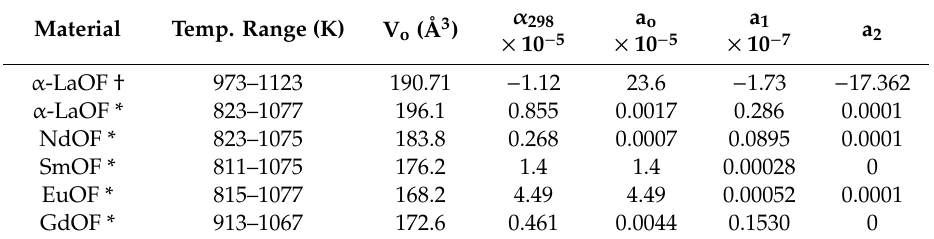
Table 7. Calculated thermal expansion coefficients for cubic REE-oxyfluorides. Material Temp. Range (K)